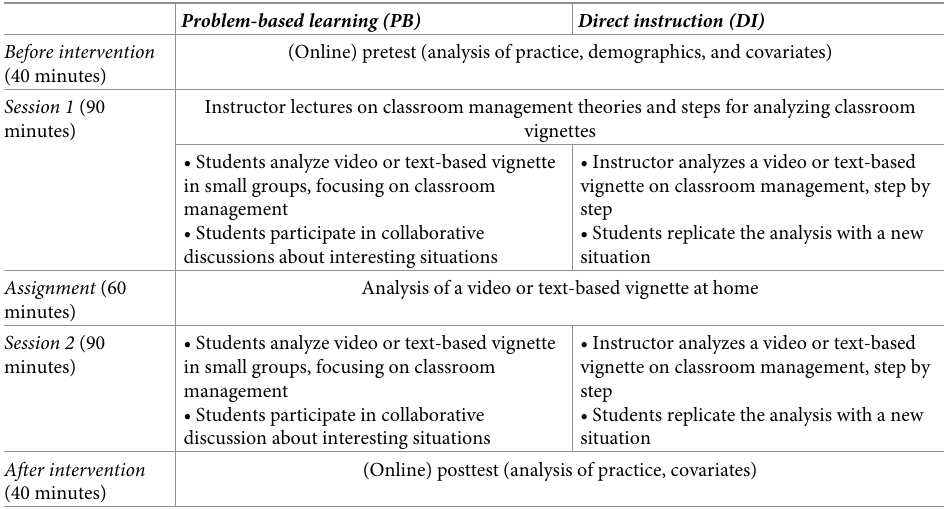
Table 1. Procedure for measurement and